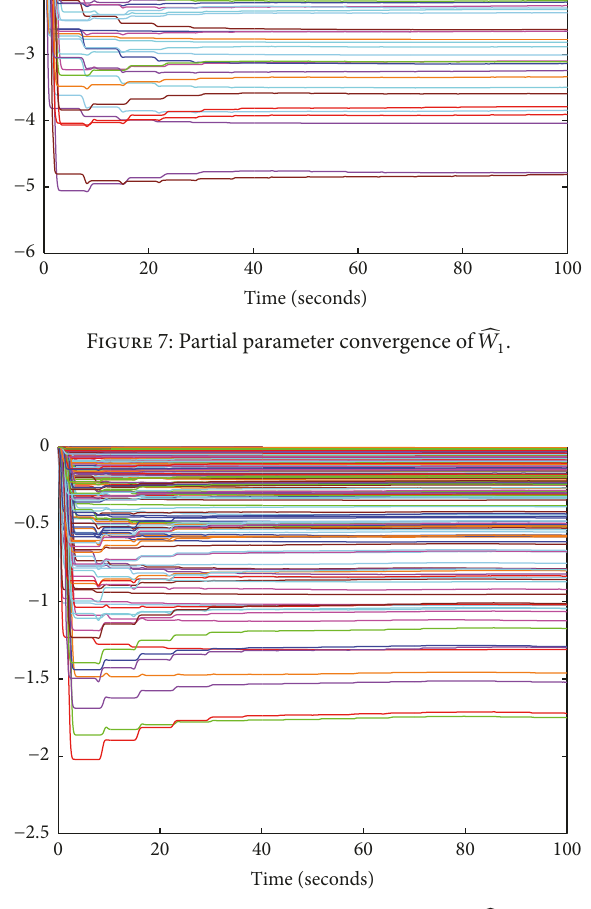
Figure 8: Partial parameter convergence of